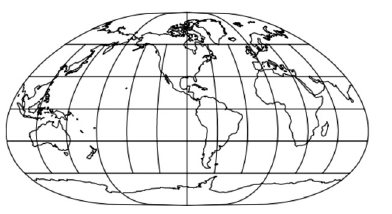
Fig. 1. Loximuthal projection (J.P. Snyder 1987)